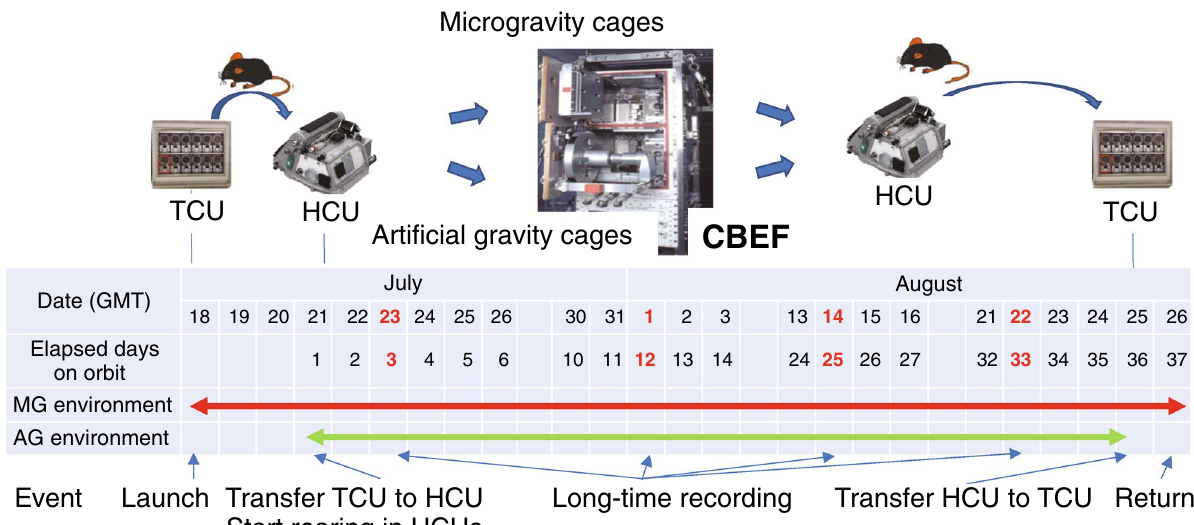
Figure 1. FL experimental event date. Twelve male mice were launched to ISS on July 18, 2016. Then the mice were transferred from TCU to HCU on July 21, 2016, divided into two groups (six mice in MG and six mice in AG) and installed into CBEF. Before reaching the ISS, the mice were exposed in MG environment for about 3.5 days. During on board period, videos were taken on the dates indicated in red. The mice were returned to the earth on August 26,